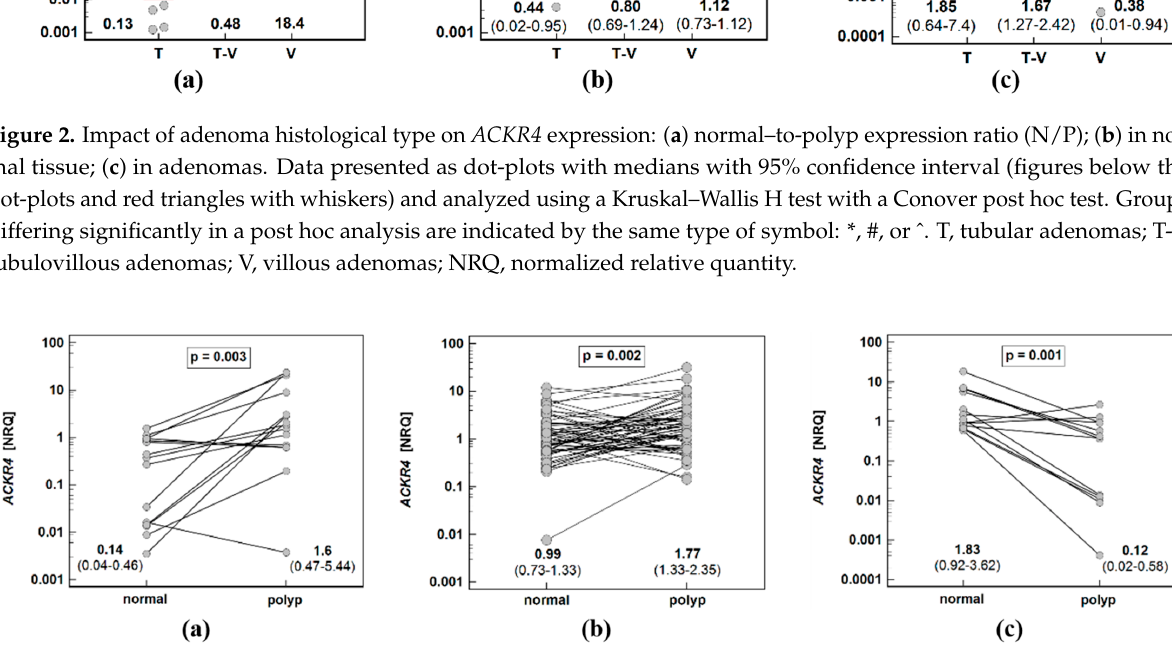
Figure 3. Pairwise analysis of ACKR4 expression in patients stratified by adenoma histological type: ( a ) tubular adenomas; ( b ) tubulovillous adenomas; ( c ) villous adenomas. Data presented as dot-plots and mean (95% confidence interval) and analyzed using t -test for paired samples. NRQ, normalized relative